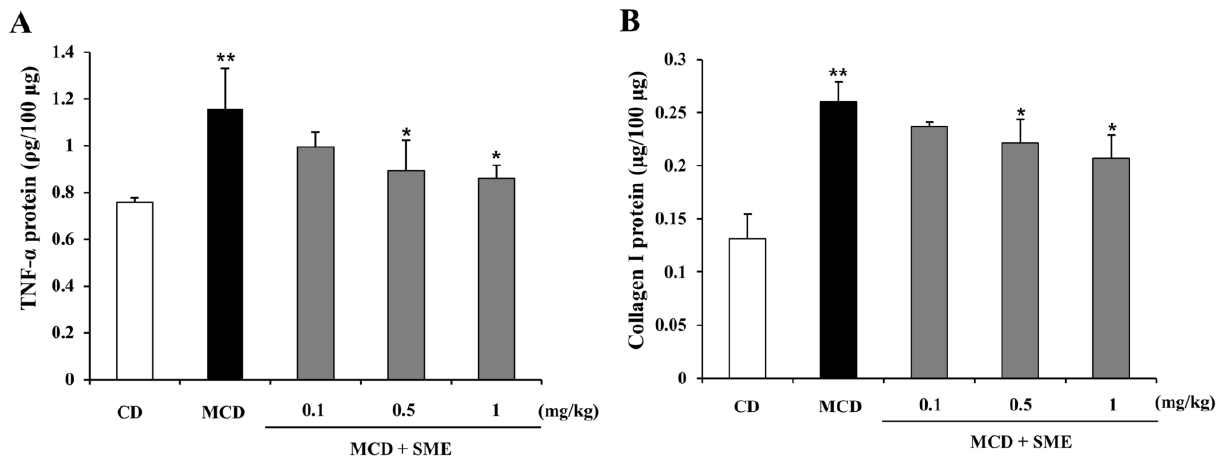
Figure 5. Effect of SME on hepatic TNF-α and collagen I protein levels in mice fed the MCD diet Comparison of mice fed with MCD diet only for 12 weeks (control) and treated with SME or vehicle by oral gavage from week 9 to 12. ( A ) TNF-α protein level. Values are mean ± SD ( n = 5–7 per group), ** p < 0.01 vs. control diet; * p < 0.05 MCD diet vs. SME treated; ( B ) Collagen I level. Values are means ± SD ( n = 5–7 per group), ** p < 0.01 vs. control diet; * p < 0.01 MCD diet vs. SME